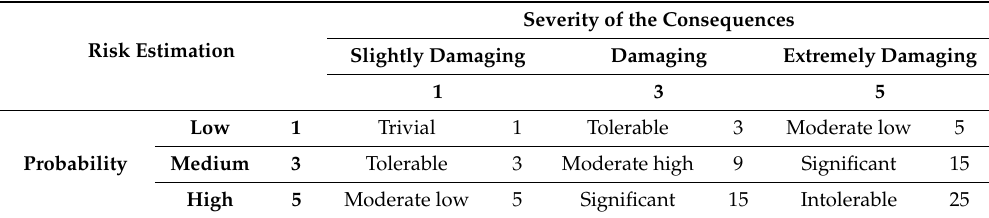
Figure 4. Quantification of risk tolerance. By scaling the X-axis and plotting the quantitative values of risk tolerance (1, 3, 5, 9, 15, and 25) we obtain the graph which quantifies absolute risk (Figure 5). These values and the graph serve as the basis for determining the rest of the parameters for the level of preventive action. This quantification procedure is carried out using the compulsory risk assessment set out in the Health and Safety at Work Plan.